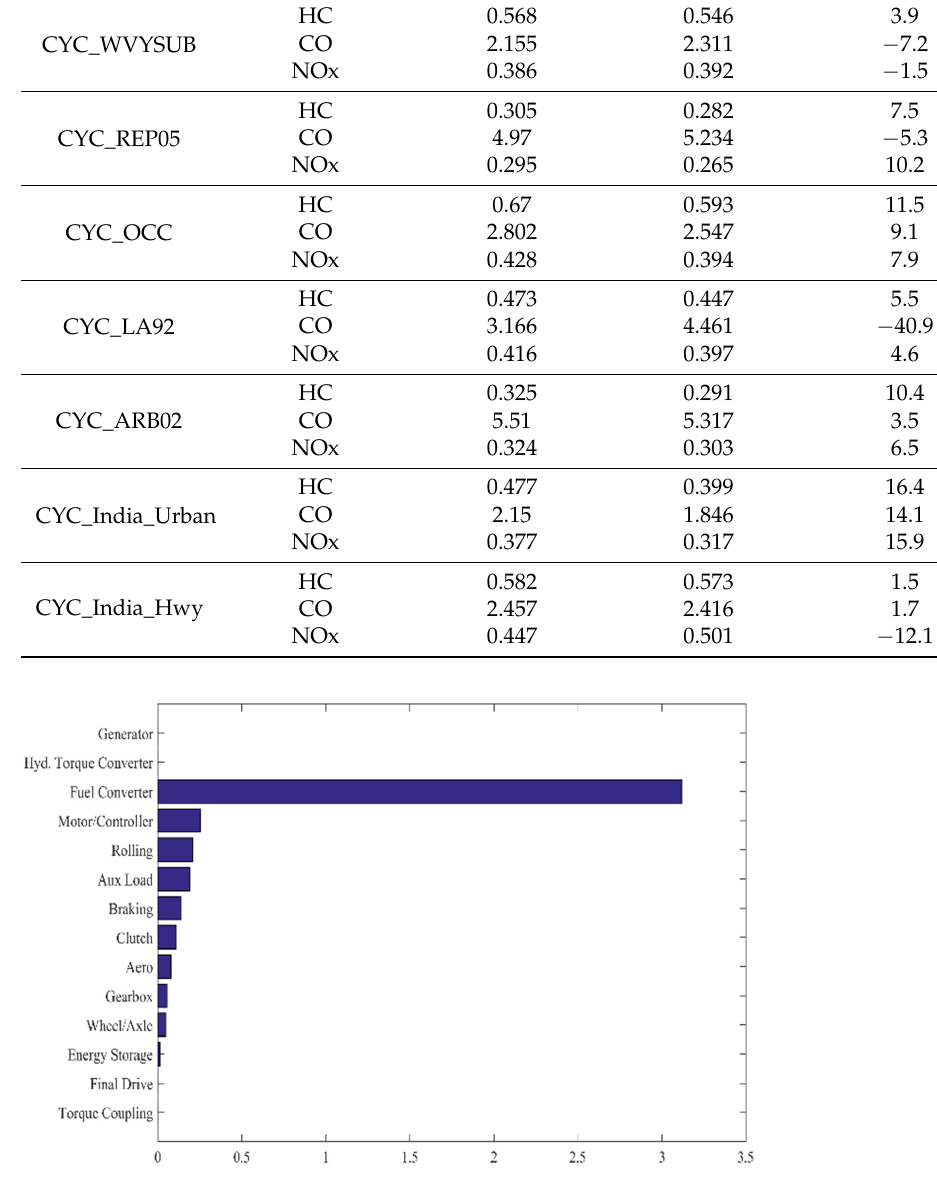
Figure 10. Energy usage (kJ) of HEV before optimization.